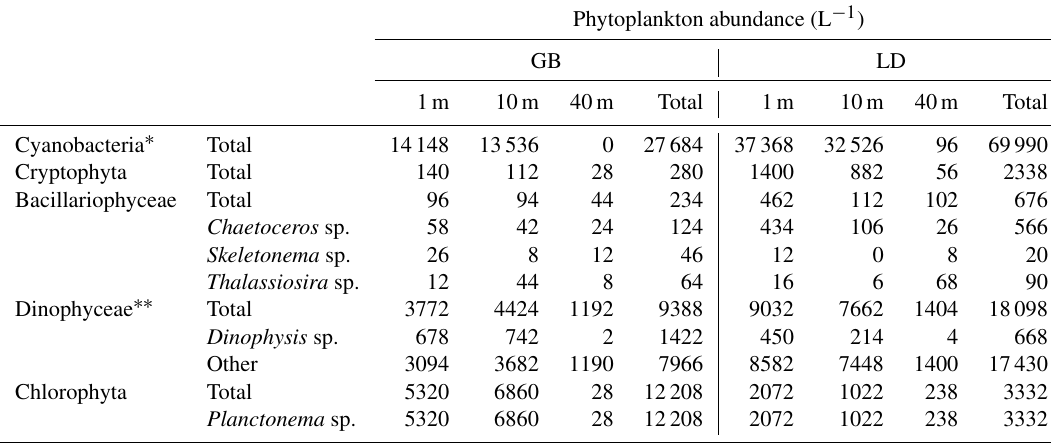
Table 3. Phytoplankton abundance analyzed microscopically for samples collected at the location of trap deployment in GB and